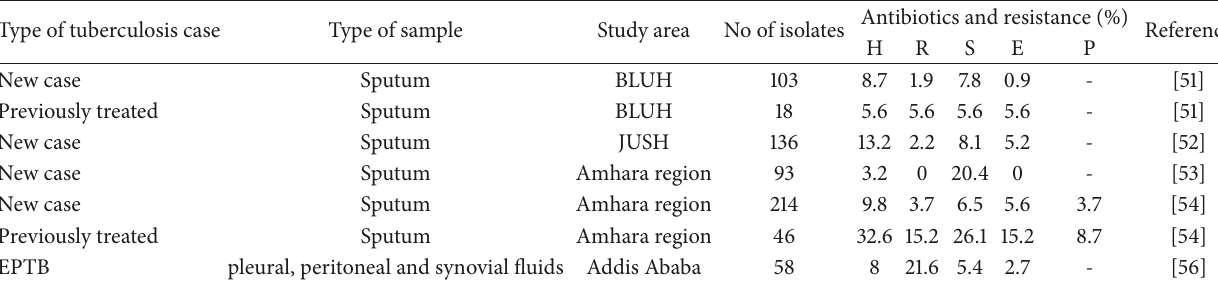
Table 3: Resistance pattern of M. tuberculosis for anti-tuberculosis drugs.